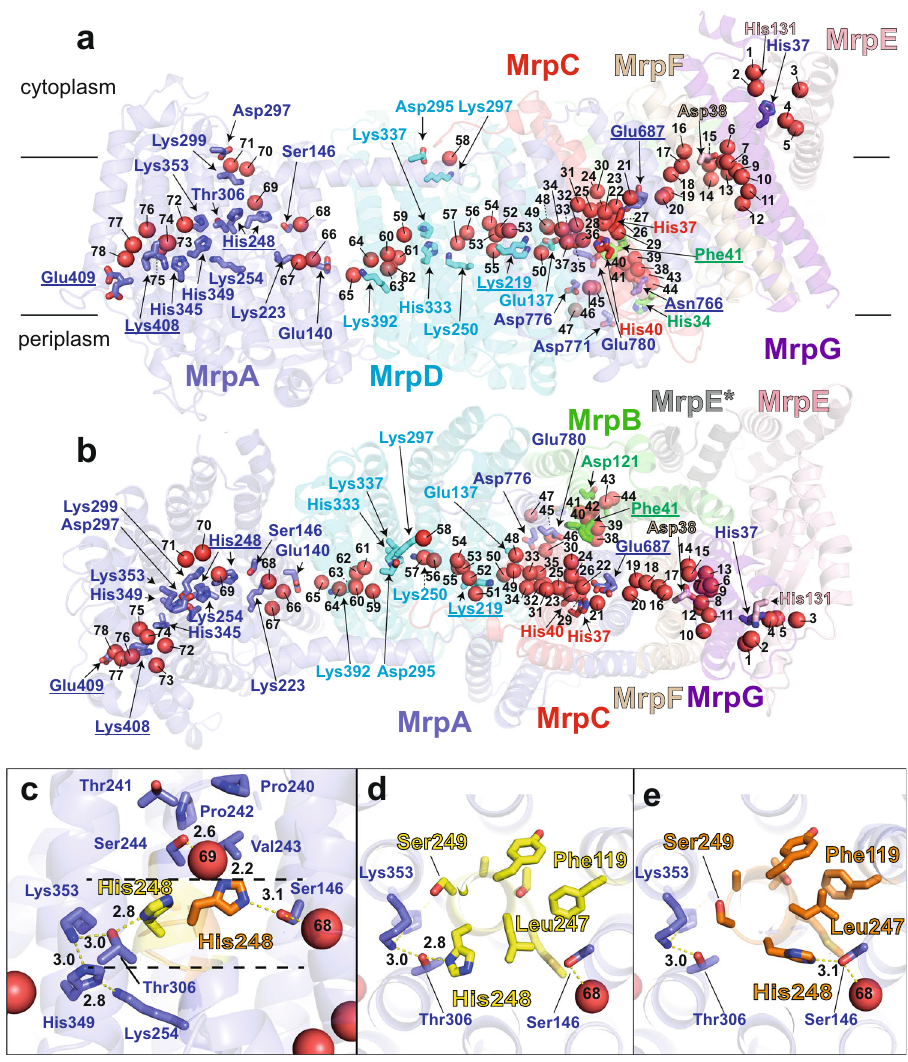
Fig. 2 | Water molecules, alternative conformations, and functionally impor- tant residues. a Side view and b top view of antiporter complex (colors compare Fig. 1) with 78 protein-bound water molecules (red spheres) in putative ion trans- location pathways. Selected residues are shown in stick representation, and labels forresiduesmodeledwithalternativeconformationsareunderlined. c Sideviewof the protein structure surrounding His248 MrpA . In the A conformation (yellow),